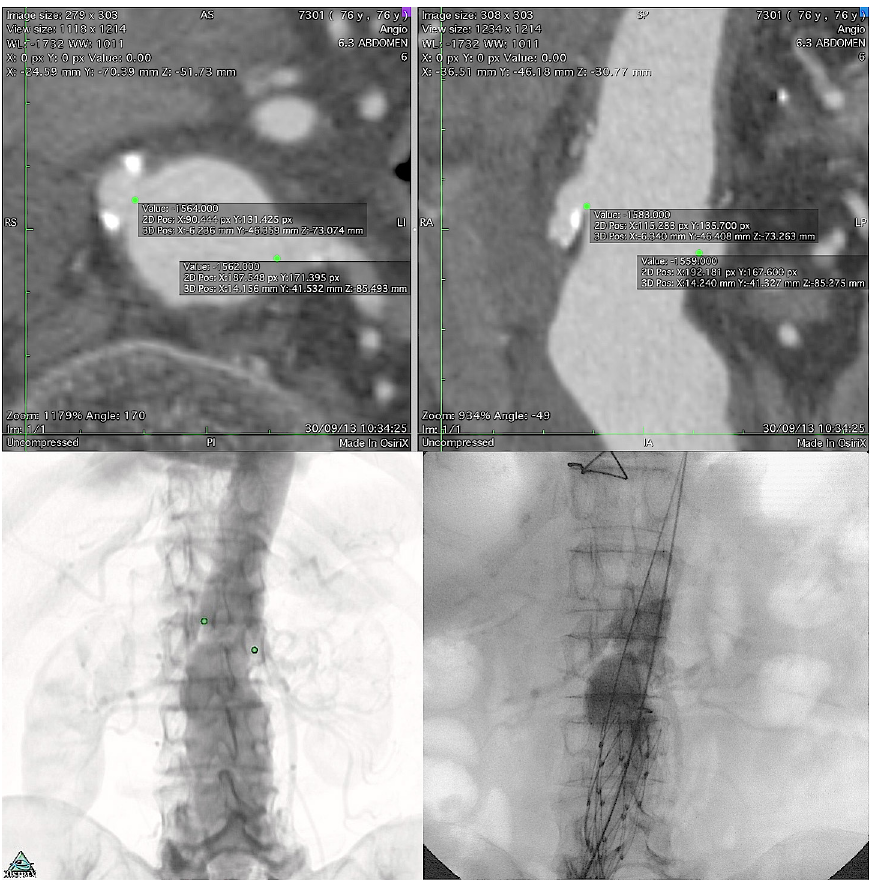
Fig. 2 - Up - ostial renal artery markings in axial projection, with auxiliary view on longitudinal section (at